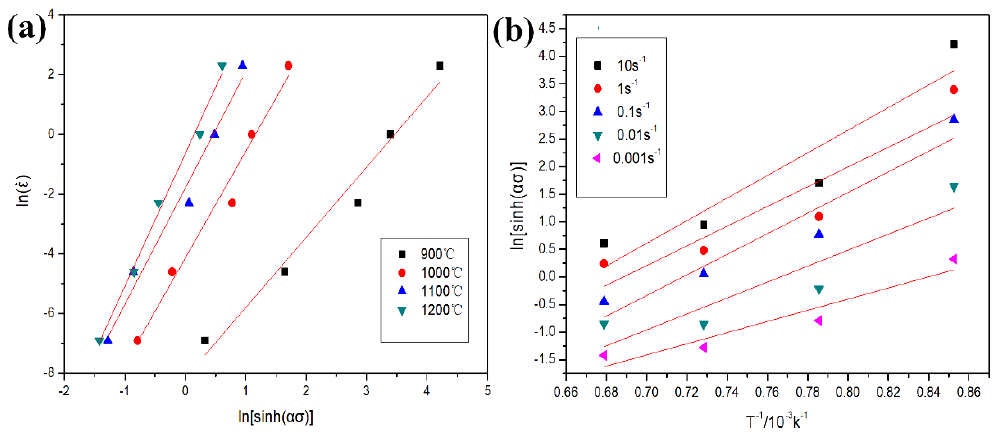
Figure 4. ( a ) Arrhenius plot of ln ε versus ln(sinh( ασ )); ( b ) the Arrhenius plot of ln(sinh( ασ )) versus 1/ T.